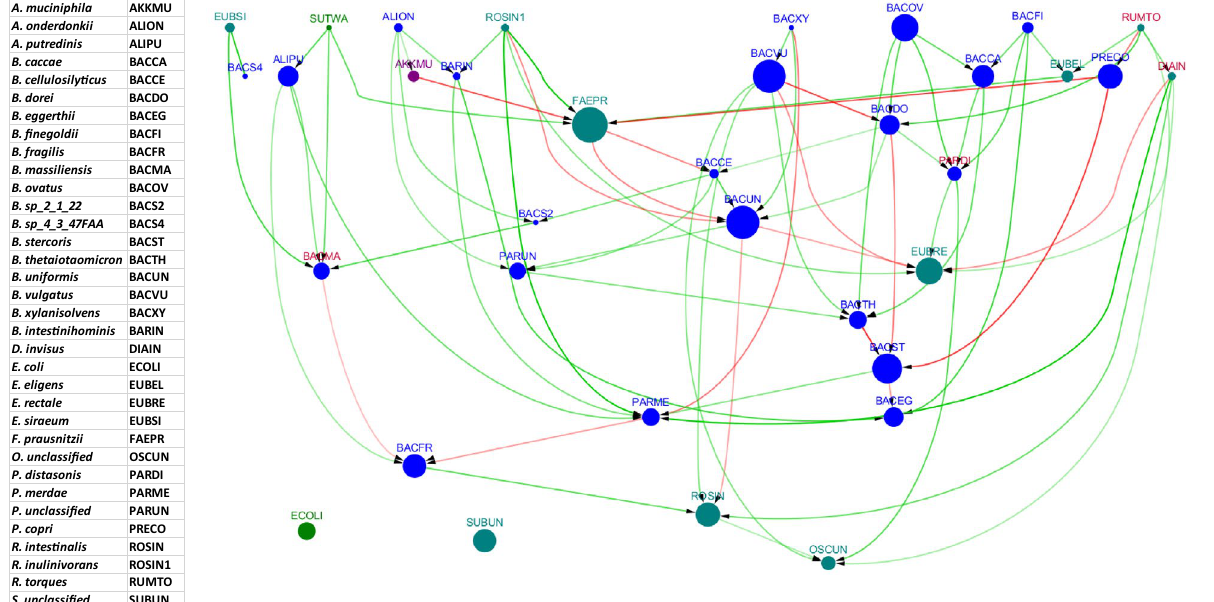
Figure 5. Causal network inferred from the data on subjects with UC from the iHMP data set. In this and all networks to follow, all directed edges point downward. The labels of potentially pathogenic bacteria are in red font. The log-likelihood score for the network along with a table of abbreviations used for the microbial taxa can be found to the left of the network. This figure was generated using the R package, bnlearn 31 , and visualized using Cytoscape 3.5.0 40